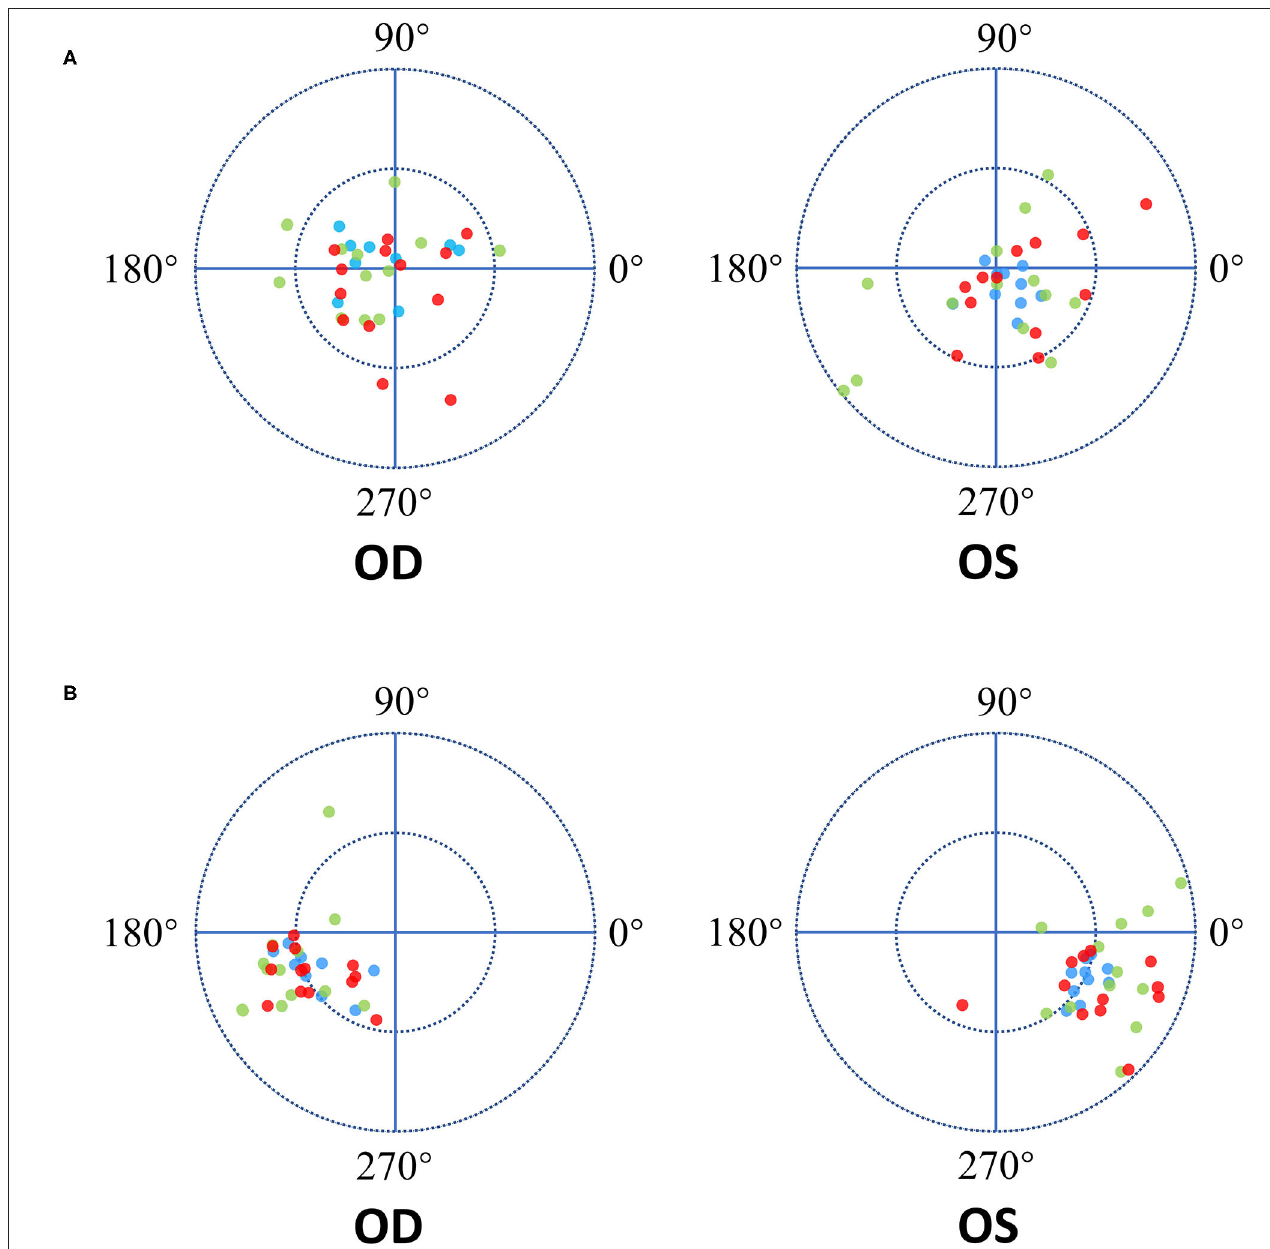
FIGURE 2 | The Diagram of IOL decentration and tilt direction. The length between the dot and the origin of coordinates is the decentration and tilt magnitude. The azimuth represented the orietation of IOL tilt and decentration in degree. Zero-degree was in the nasal side of the patient’s right eye and in the temporal side of the patient’s left eye. OD represent the right eye of patient while OS represent the left eye. The red dots represent the Closed C-loop IOLs, the green dots represent the C-loop IOLs and the blue dots represent the Plate IOLs. (A) Each ring = 0.3mm. The blue dots showed more concentrated on the origin of coordinates in both eyes. And there was not obvious tendency of the IOLs decentration direction in both eyes. (B) Each ring = 5 ◦ . The tendency of IOLs tilt direction was toward the inferotemporal direction in the both eyes.